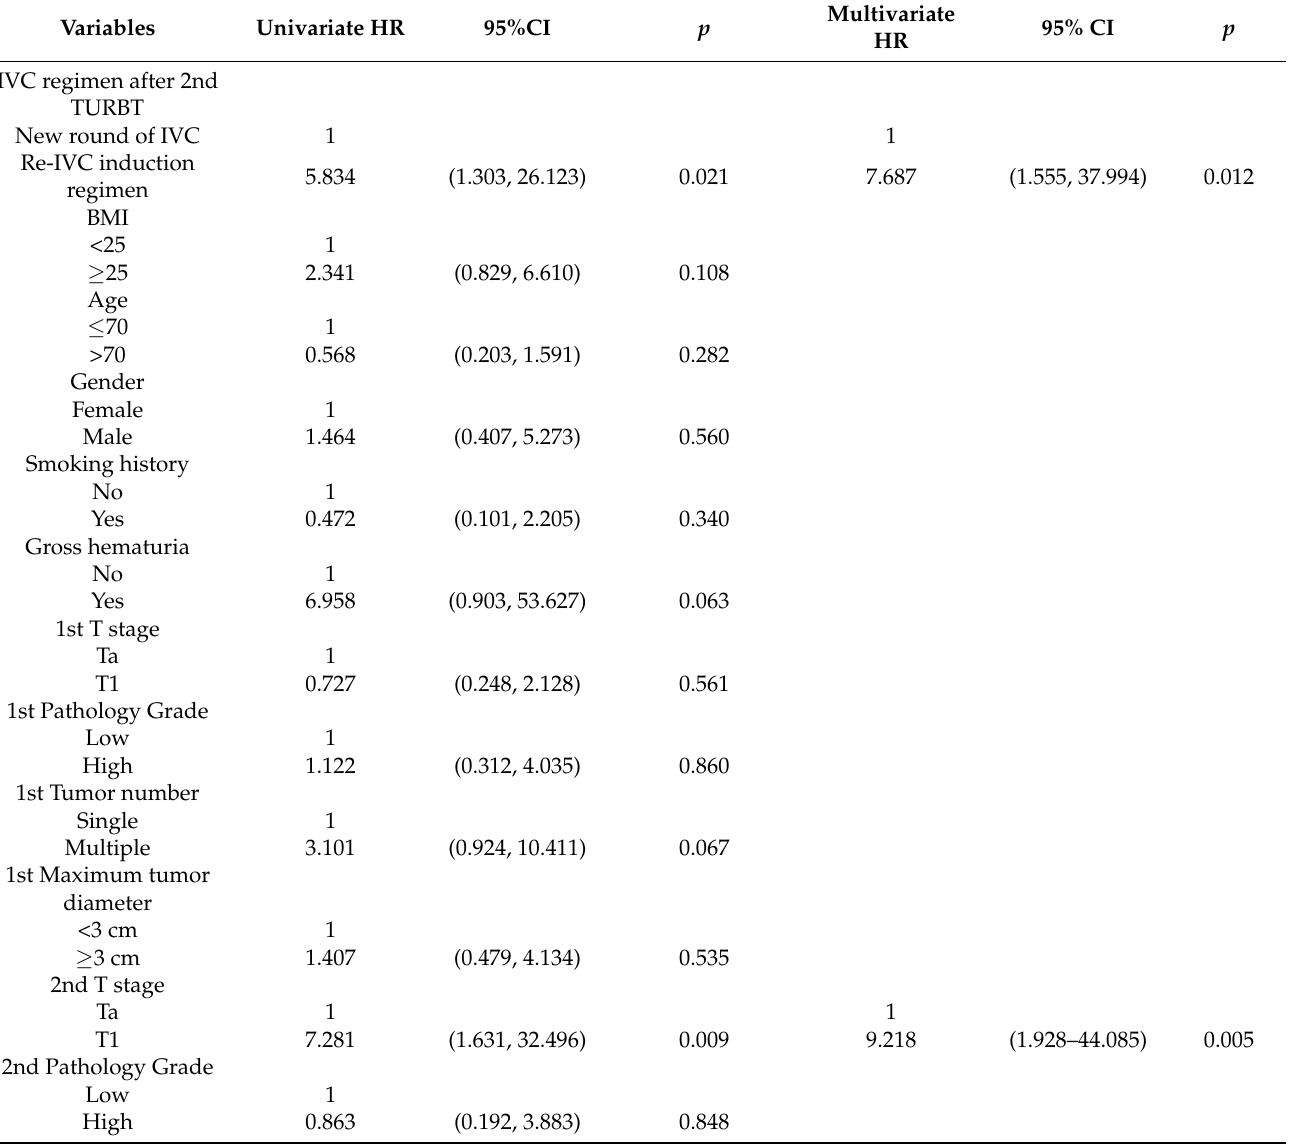
Table 2. Univariate and multivariate analysis of factors influencing